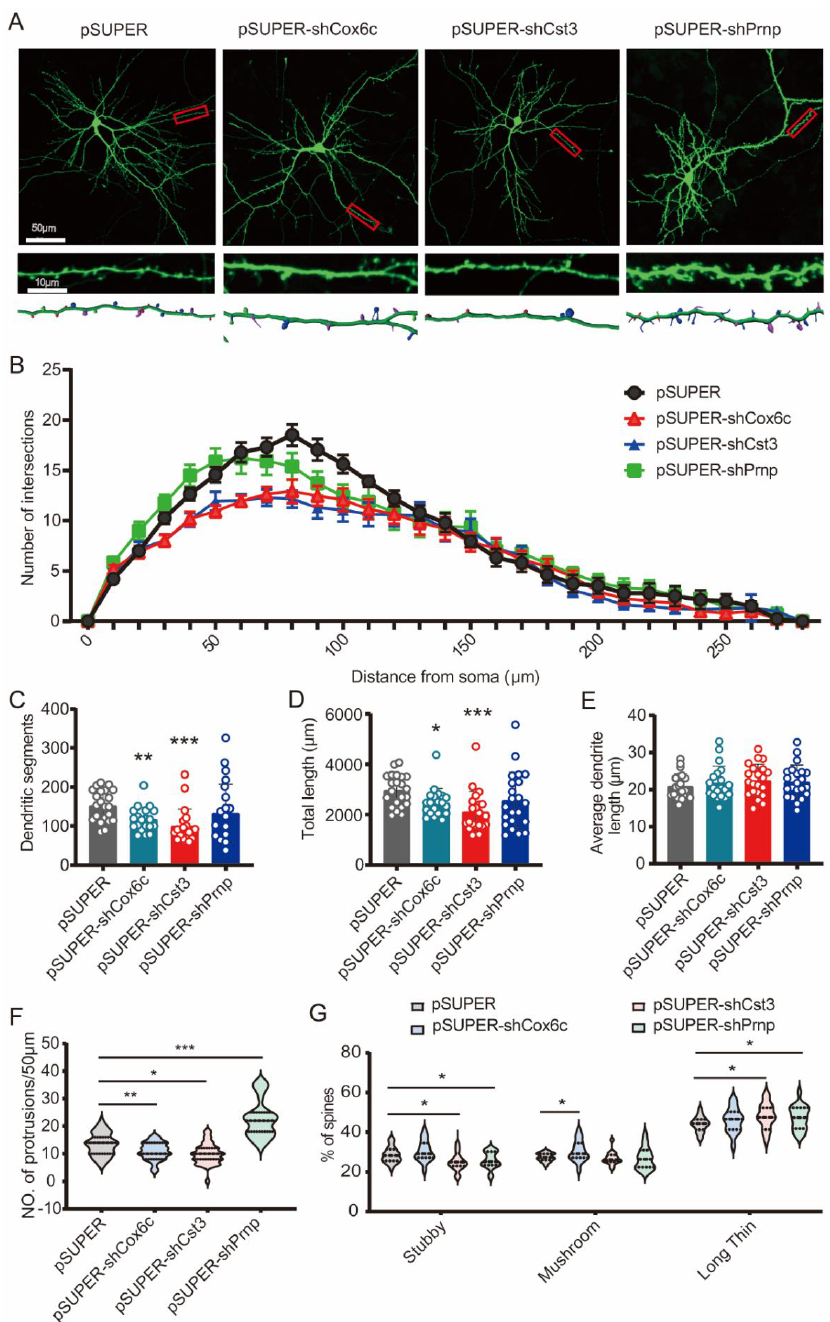
Figure 5. Downregulation of Cox6c, Cst3, or Prnp alters dendritic spine density and morphology. ( A ) Rat hippocampal neurons were transfected at 12 days in vitro (DIV) with pSUPER-GFP plus pSUPER-shCox6c, pSUPER-shCst3, and pSUPER-shPrnp, respectively. Confocal images (40×) were collected at DIV 14. Scale bar: ( top ), 50 μm; ( bottom ) : 10 μm. Representative images of GFP in transfected neurons are shown, along with magnified images of the dendritic protrusions. Imaris 3D reconstructions used to quantitatively analyze dendritic spines are shown below. ( B ) Sholl analysis of dendritic arbors. ( C ) Numbers of dendritic segments quantification. ( D ) Analysis of total dendritic length. ( E ) Analysis of average dendritic length. ( F ) Quantitative analysis of dendritic spine densities (total of 20–25 cells from 3 independent experiments). ( G ) Spine classifications and quantification of stubby, mushroom, or long thin spine morphology using Imaris. Data presented in 3 independent experiments (from a total of 20–25 neurons). Data are mean ± SEM; * p ≤ 0.05, ** p ≤ 0.01, *** p ≤ 0.001; two-way